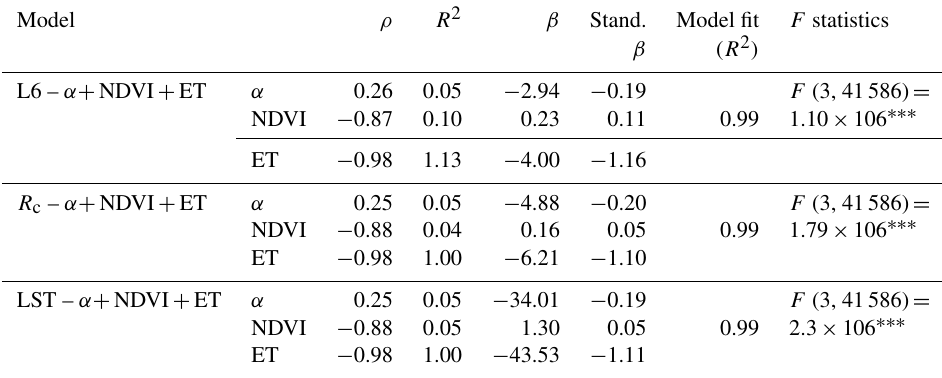
Table 1. Statistical analysis between biophysical variables (albedo ( α) , NDVI and ET) and spectral radiance band (L6), corrected thermal band ( R c ) and Landsat land surface temperature (LST). Model ρ R 2 β